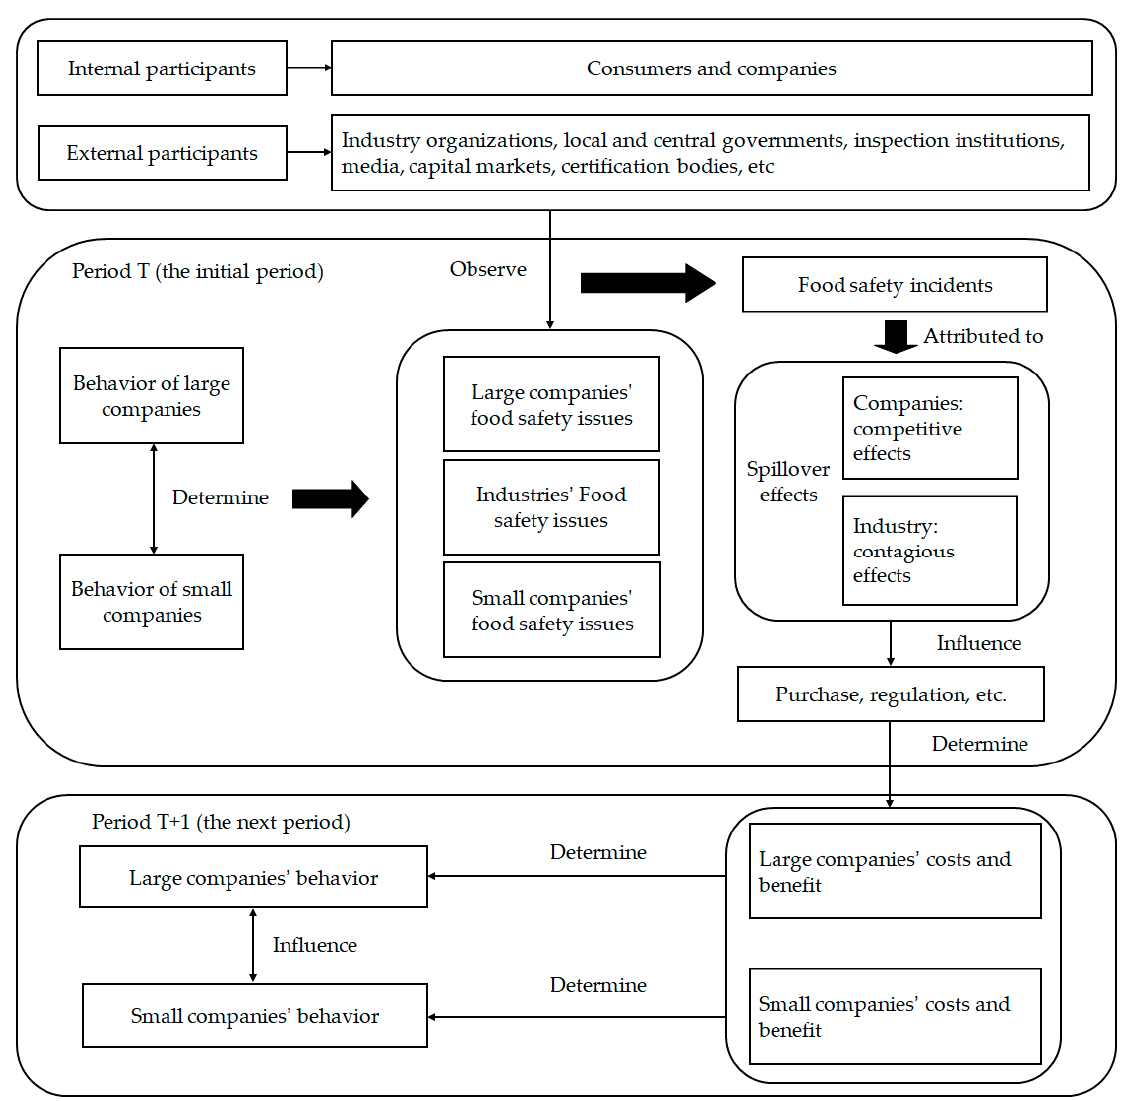
Figure 2. Analysis of the formation mechanism of companies’ food safety strategies.